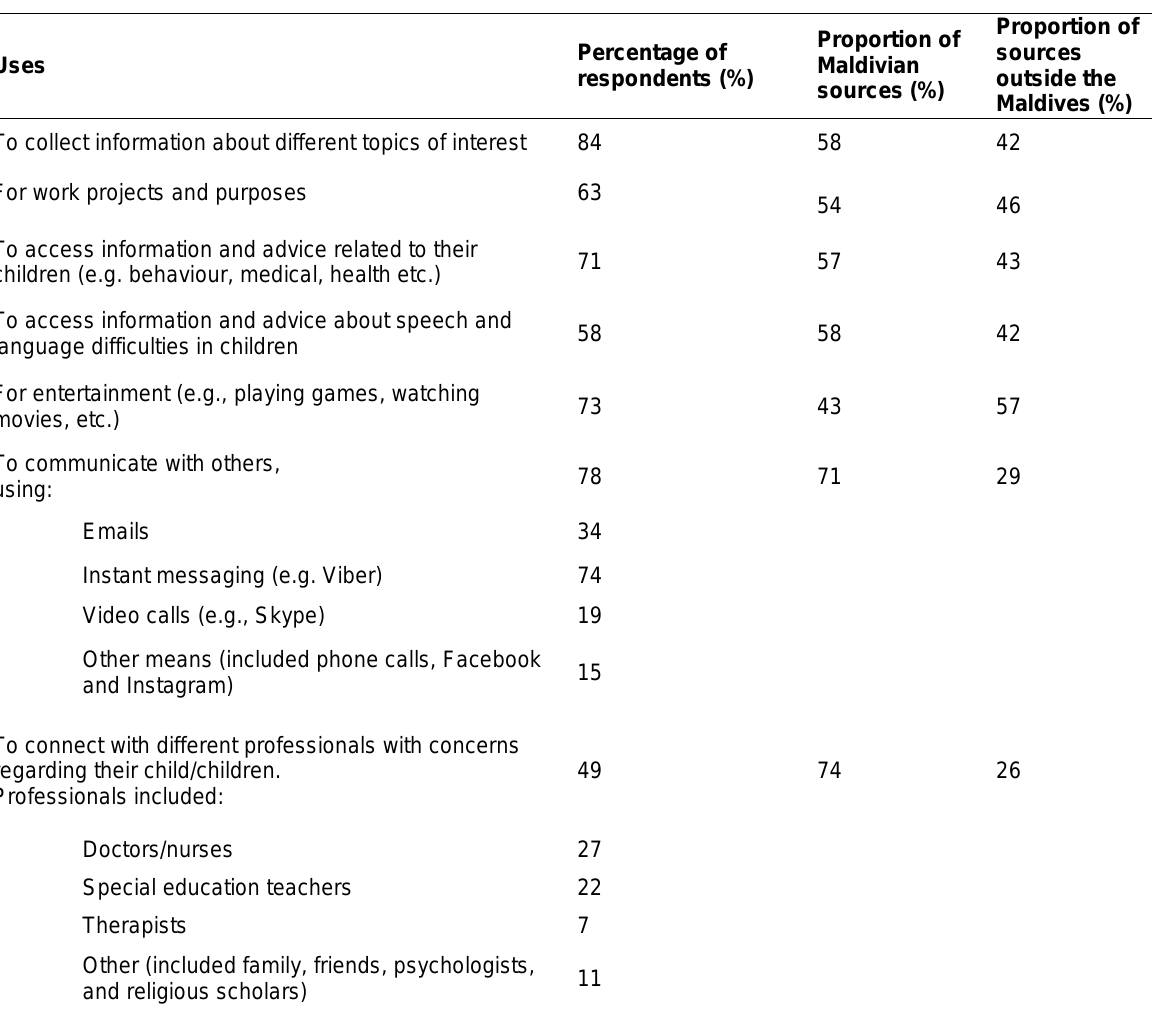
Table 3. Internet and ICT uses by Parents